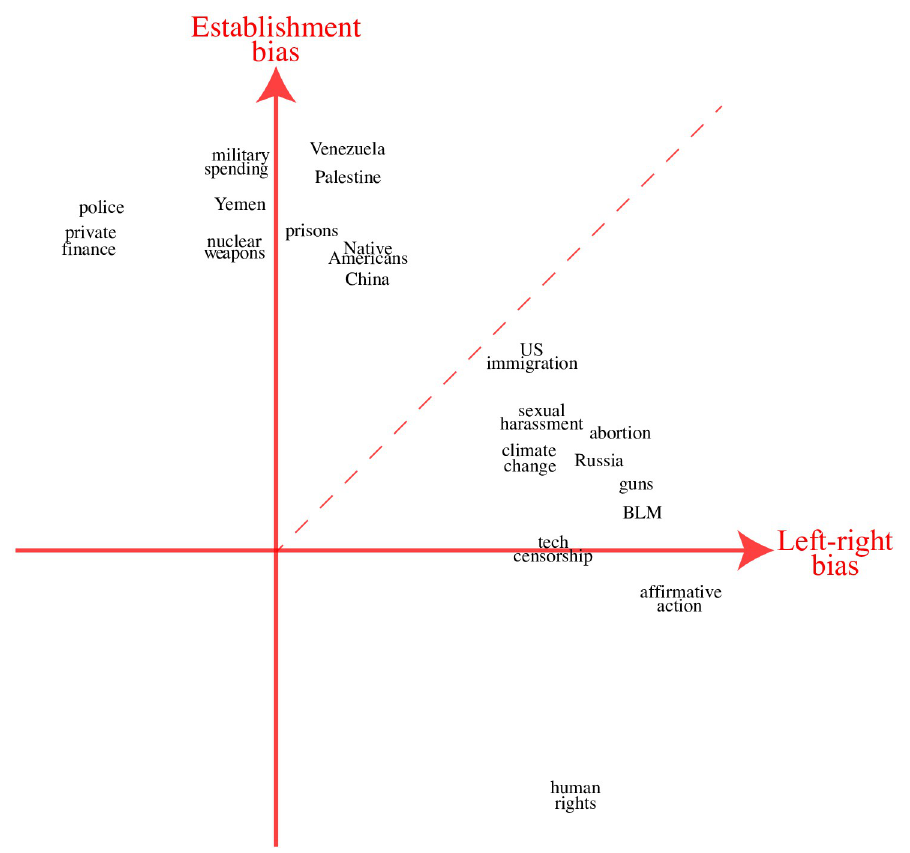
Fig 13. Spectral clustering of topics by their media bias characteristics as explained in the text. The bars represent 1 standard deviation Jackknife error bars.